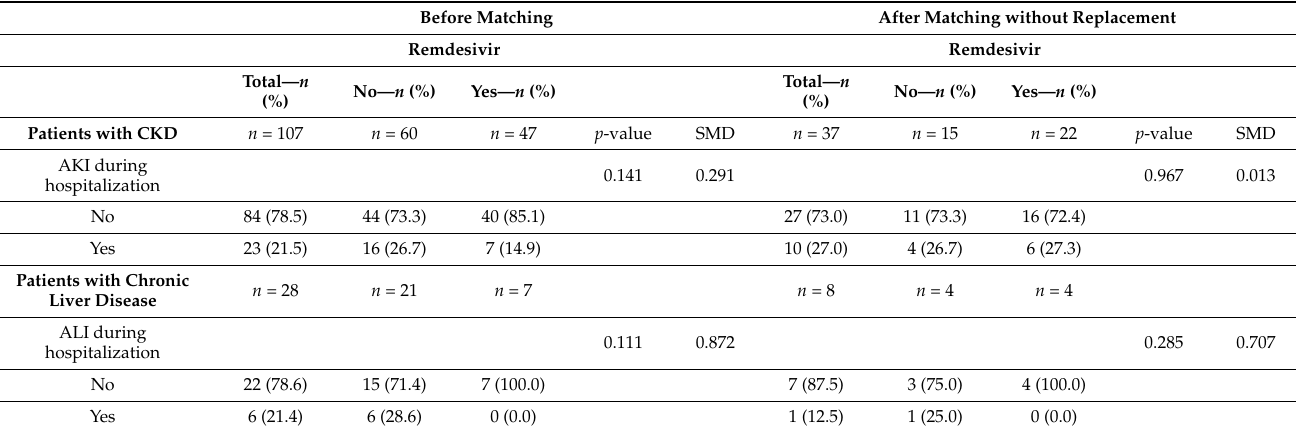
Table 4. Subgroup Analysis for patients with chronic kidney disease and chronic liver